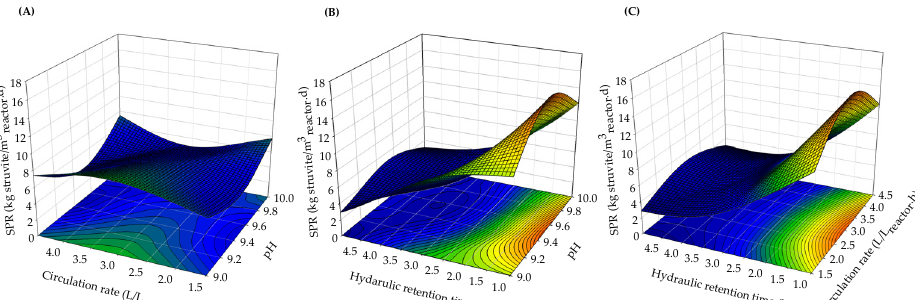
Figure 5. 3D response surface plots showing the effects on struvite production rate of: ( A ) pH × circulation rate, ( B ) pH × hydraulic retention time, and ( C ) circulation rate × hydraulic retention time.